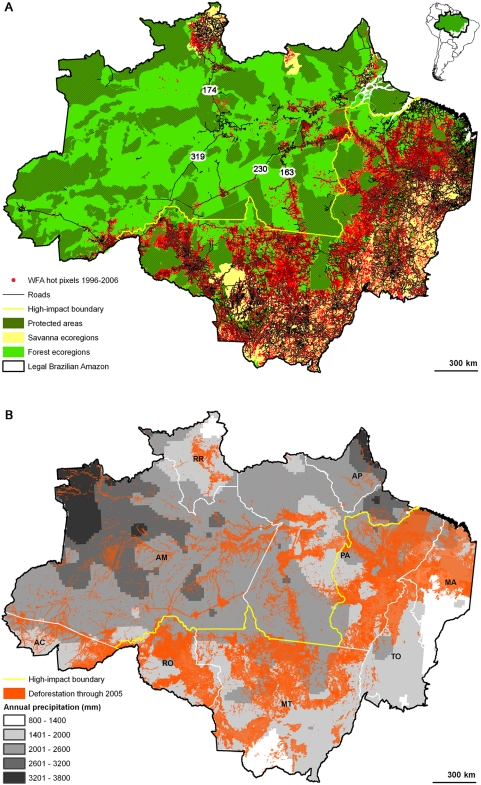
Fire and deforestation in the Brazilian Amazon.A) The Legal Brazilian Amazon showing reserves and World Fire Atlas hot pixels from 1996–2006. The high-impact forest is to the southeast and low-impact forest is to the northwest of the yellow boundary line. Roads mentioned in the text are labeled. B) PRODES deforestation polygons through 2005 against the background of annual rainfall from the WorldClim dataset. High-impact areas include the states of Rondônia [RO], Mato Grosso [MT], Tocantins [TO], Maranhão [MA] and the portion of Pará [PA] east of the Xingu River. Low-impact areas include the states of Acre [AC], Amazonas [AM], Roraima [RR], Amapá [AP] and the portion of Pará north and west of the Xingu river.